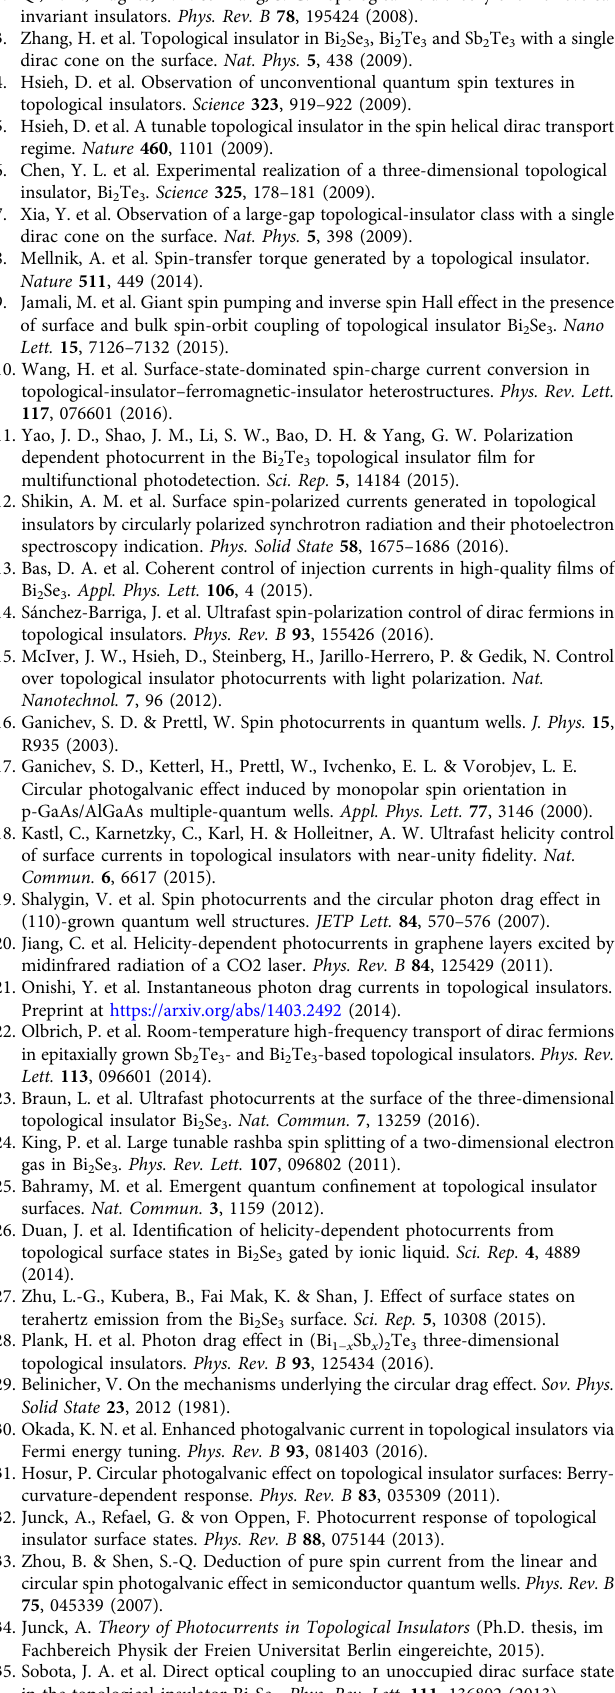
Table 1 Parameters used for the model study